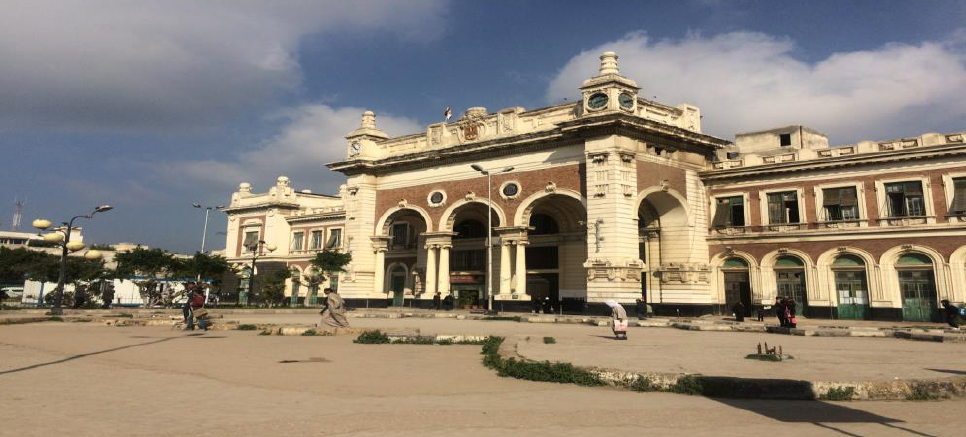
Figure 5: Egypt Railway Station Building - Alexandria (Part musings, 2015)